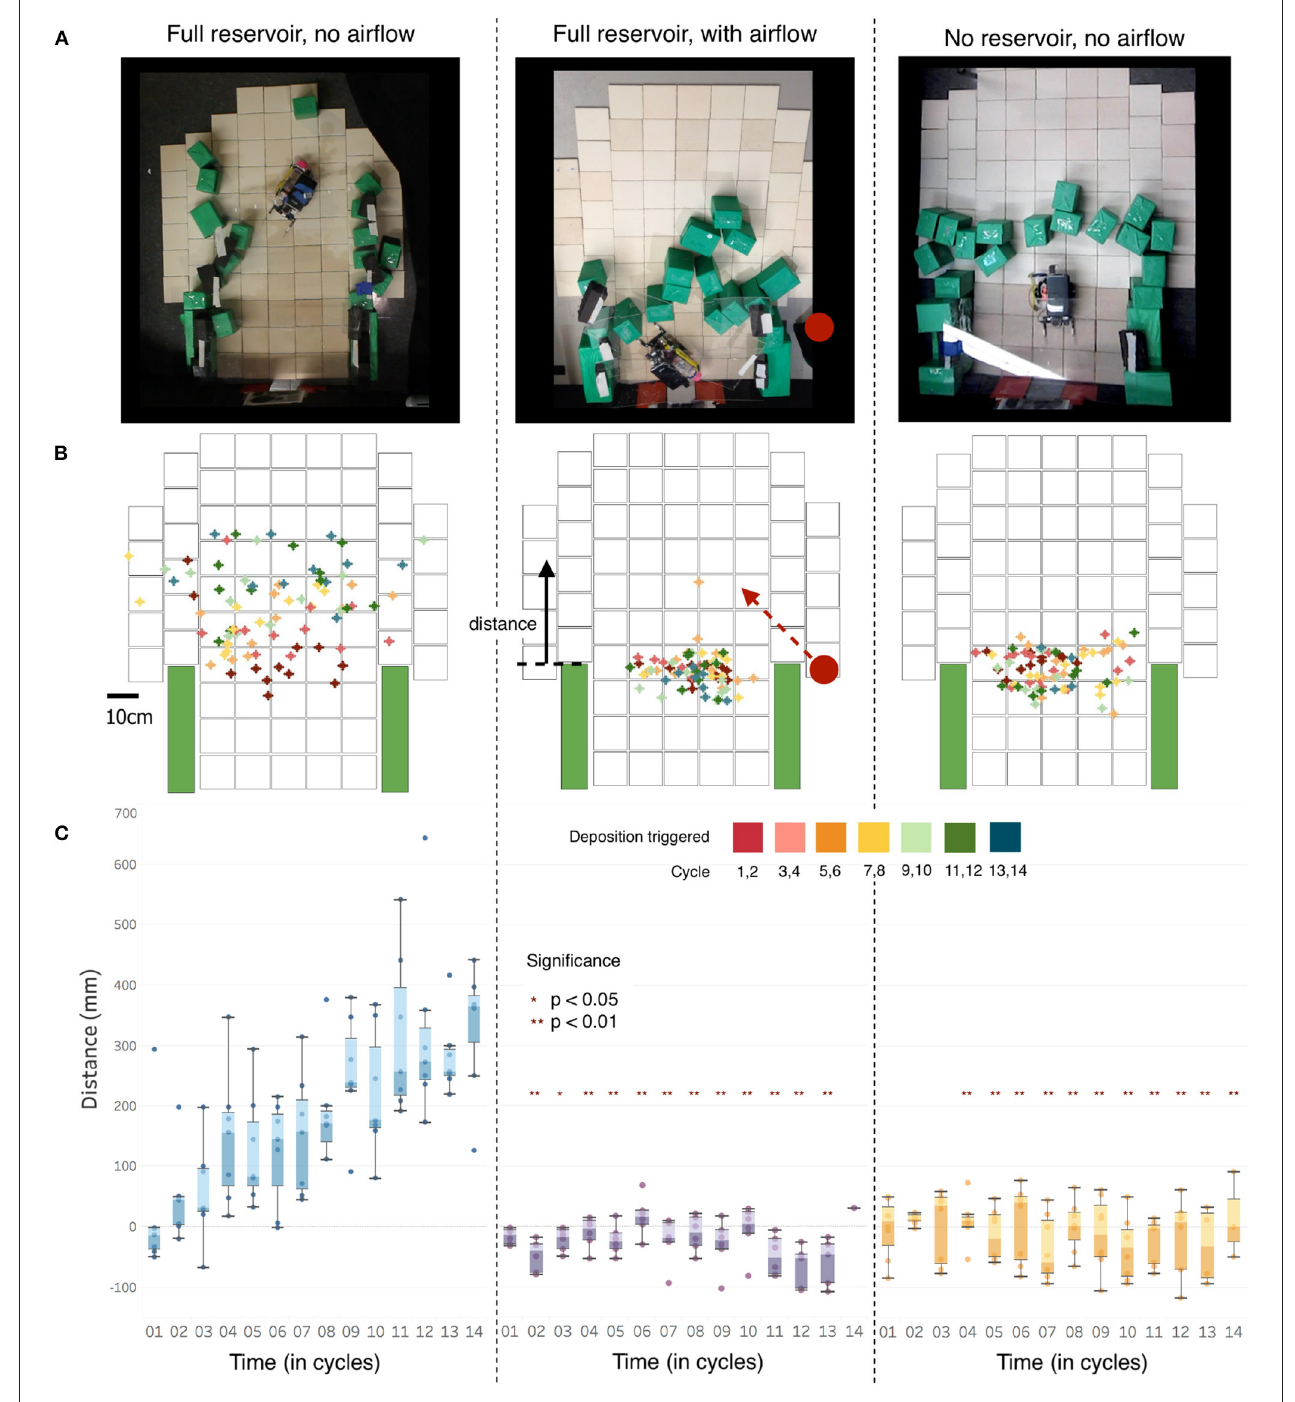
FIGURE 4 | Results of robophysical experiments. (A) End state block placements for one example run of each of the three treatments [left: robot’s water reservoir full, no external airflow; middle: external fan blowing across the arena from the right hand side (fan direction was alternated between experiments); right: no fan, water reservoir empty]. (B) Locations where measured humidity dropped below threshold (75% RH), triggering block deposition, superimposed for all trials for each condition. Cycle sequence is indicated by color of the location marker (inset), showing the change in trigger location over time. Fan position, shown by a red dot on the right in the middle panel, was alternated between trials. (C) Comparison of the distances of the block deposition trigger points from the initial wall length [see (B) , center] for the three experimental conditions. Significance calculated via 2-tailed independent sample t -test; a minimum of n = 6 trials was conducted for each experimental